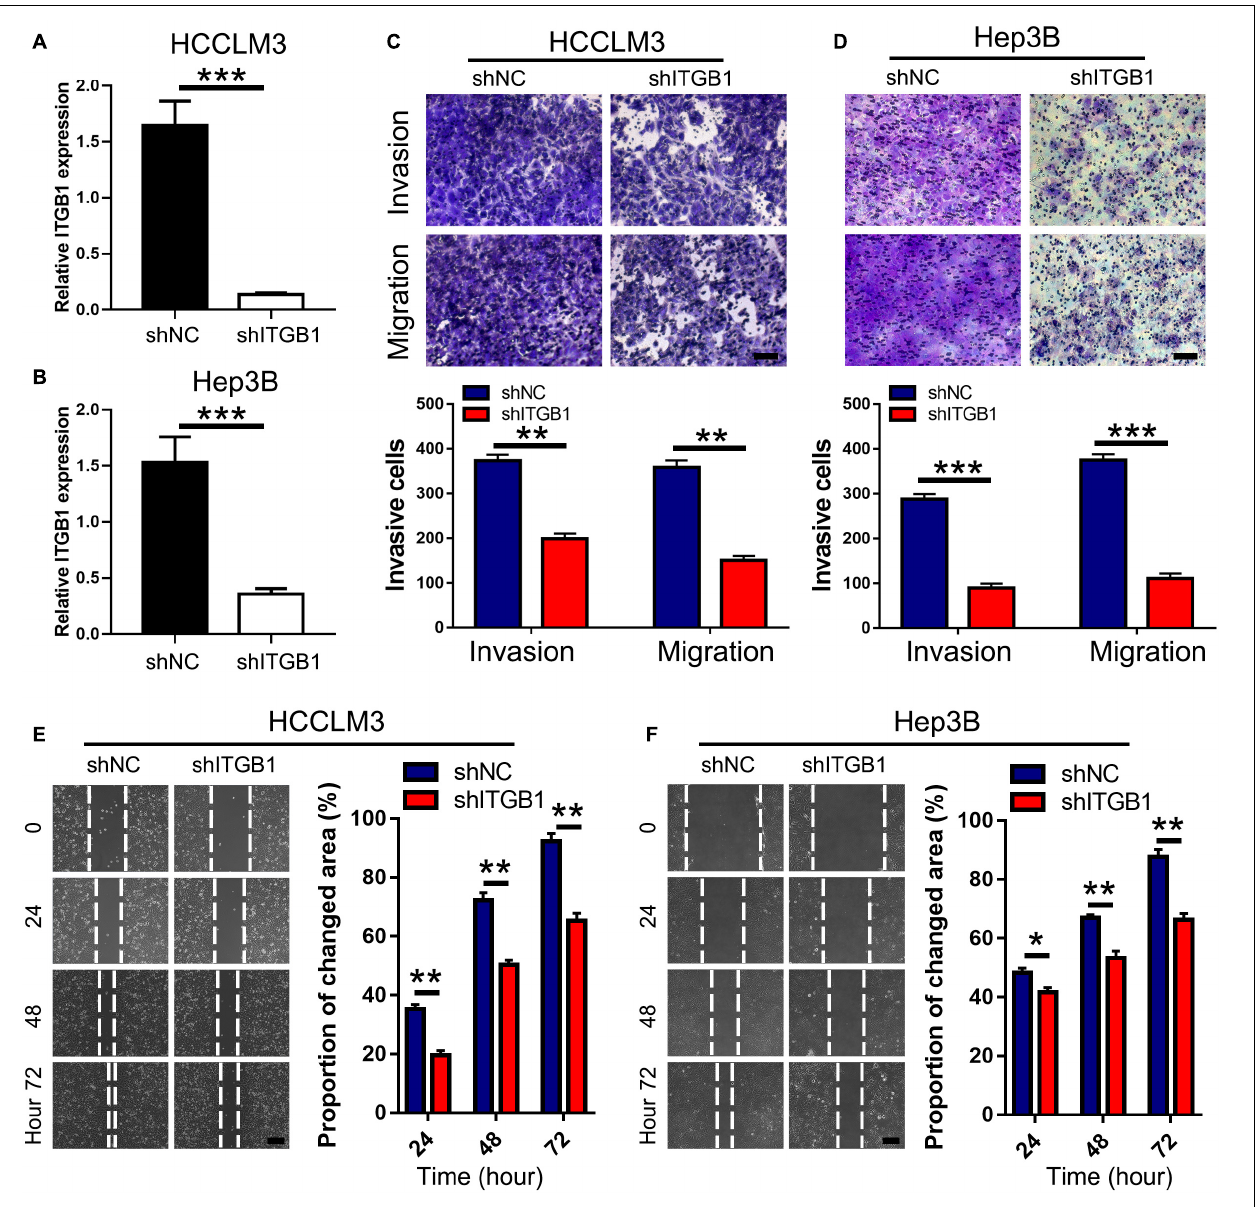
FIGURE 6 | Integrin β 1 downregulation inhibits migration and invasion of HCC cell lines. (A,B) Results of qRT-PCR validated the integrin β 1 knockdown in HCCLM3 (A) and Hep3B (B) cells. (C,D) Transwell assays for HCCLM3 (C) , and Hep3B (D) cells transfected with integrin β 1 specific shRNA or the negative control. Scale bars, 100 µ m. (E,F) Wound-healing assays for HCCLM3 (E) , and Hep3B (F) cells transfected with integrin β 1 specific shRNA or the negative control. Scale bars, 200 µ m. ITGB1, integrin β 1. Data presented as mean ± SEM. * P < 0.05, ** P < 0.01, and *** P < 0.001, Student’s t